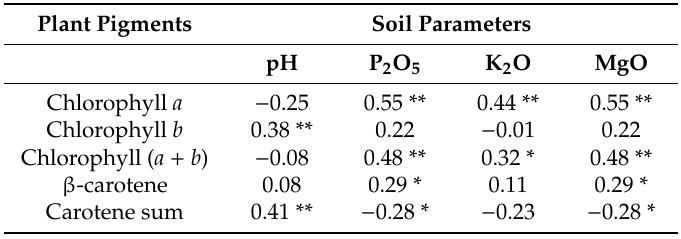
Table 6. Spearman’s rank-order correlation coe ffi cients between the content of chlorophyll pigments in the leaves and the mineral content of the soil. Plant Pigments Soil Parameters pH P 2 O 5 K 2 O MgO Chlorophyll a − 0.25 0.55 ** 0.44 ** 0.55 ** Chlorophyll b 0.38 ** 0.22 − 0.01 0.22 Chlorophyll ( a + b ) − 0.08 0.48 ** 0.32 * 0.48 ** β -carotene 0.08 0.29 * 0.11 0.29 * Carotene sum 0.41 ** − 0.28 * − 0.23 − 0.28 * * p < 0.05; ** p <